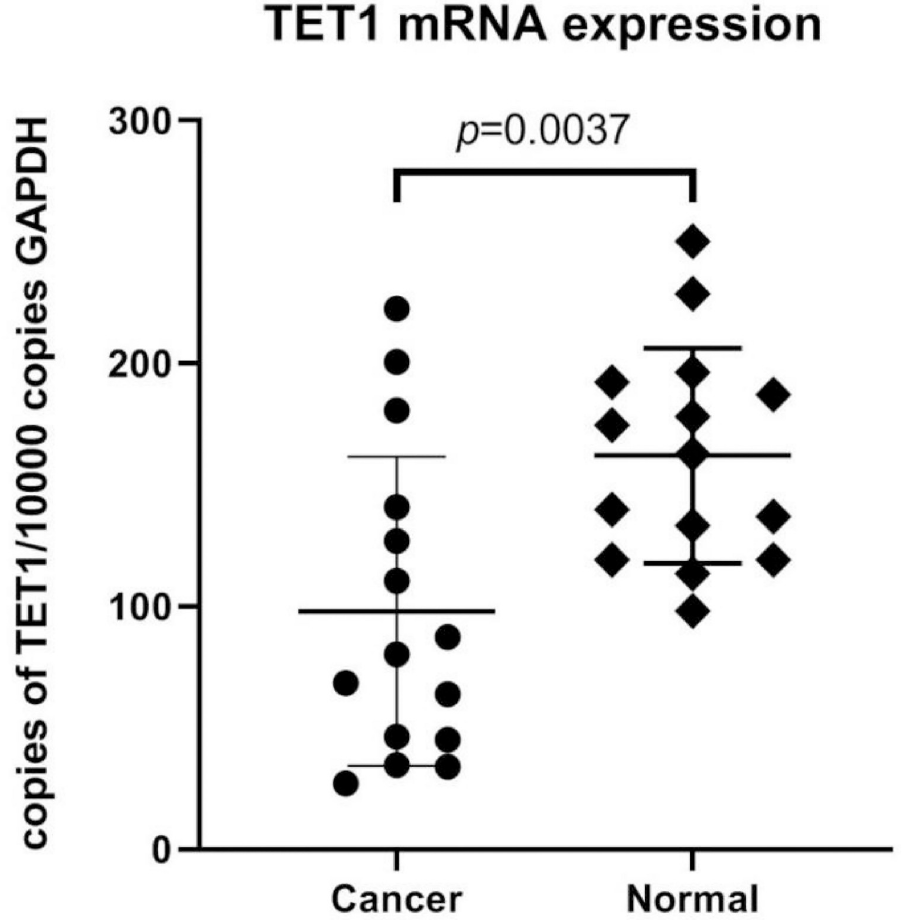
Fig 2. TET1 mRNA expression in normal endometrium and